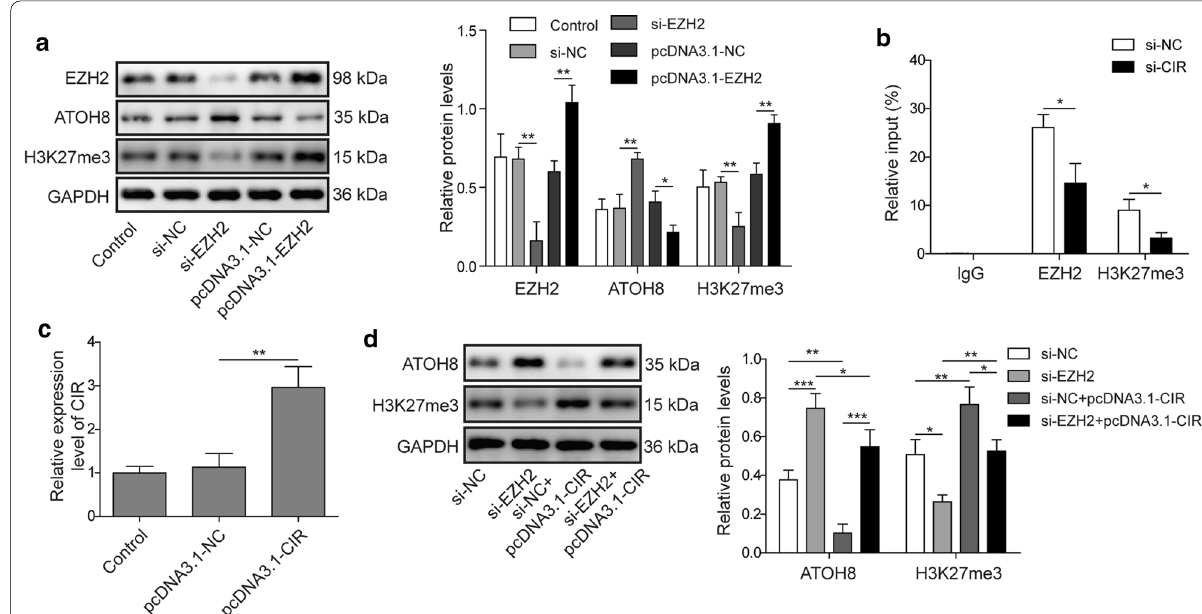
Fig. 5 LncRNA CIR binds to EZH2 and silences ATOH8 expression. a Western blot analysis of EZH2, ATOH8 and H3K27me3 in transfected cells. b ChIP analysis was performed to analyze the interactions of EZH2 and H3K27me3 with ATOH8 promoter in transfected cells. c qRT‑PCR analysis of lncRNA CIR level in transfected cells. d Western blot analysis of protein levels of ATOH8, H3K27me3 in transfected cells. n *** P <